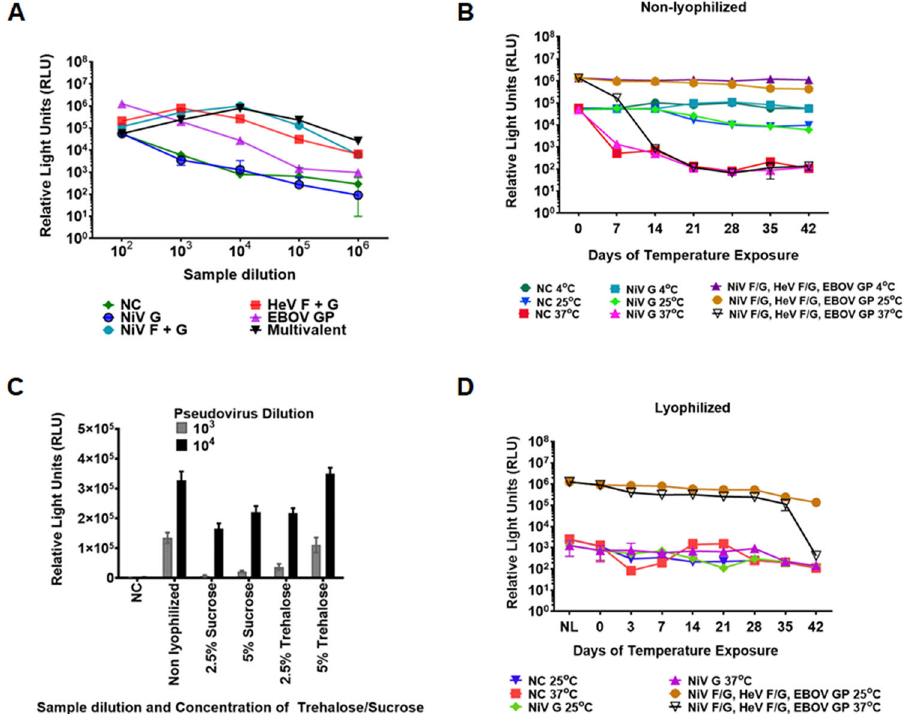
Fig. 5 Carbohydrates preserve the thermostability of pseudotyped VSV particles. A Vero cell entry capabilities for pseudotyped VSV incorporating monovalent and multivalent target proteins determined using Renilla Luciferase assay. The relative MOI of the pseudotyped VSV was determined based on luminescence produced from the Luc gene and read as relative light units (RLU). The pseudotyped VSV virions were collected 40 h post transfection. The monovalent and multivalent pseudotyped VSV virions were diluted 1:100 to 1:1,000,000 and their entry capabilities determined to assess the optimal entry levels for the monovalent and multivalent pseudotyped VSV. B Determination of Vero cell entry of non-lyophilized multivalent pseudotyped VSV exposed to 4 °C, 25 °C, and 37 °C for 42 days. C Determination of sucrose and trehalose capability to preserve the multivalent pseudotyped VSV during lyophilization. D Determination of viability for the 5% w/v trehalose preserved pseudotyped VSV. Viability was determined using the Renilla Luciferase